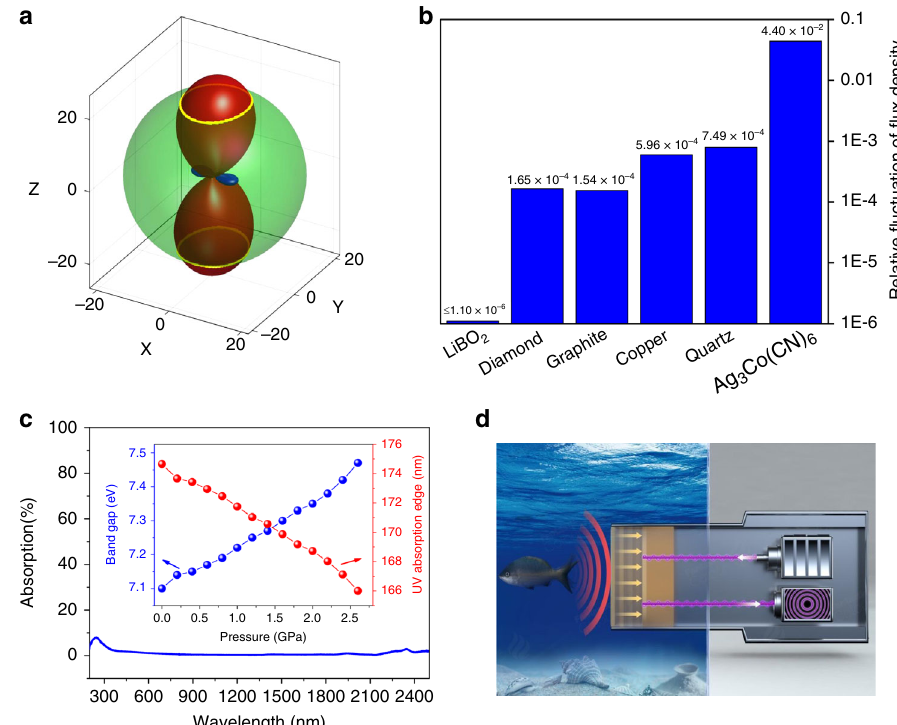
Fig. 3 Flux density stability, optical property, and potential application of LiBO 2 . a The matching between linear and volume compressibilities. Positive and negative linear compressibilities are represented by red and blue surfaces, and volume compressibility is represented by green sphere, respectively. The isoline between linear and volume compressibilities is highlighted by yellow curve. b Comparison of the relative fl uctuations of fl ux density among LiBO 2 and other materials, as they are moved from the sea level to Mariana Trench. c UV – Vis diffuse-re fl ectance spectrum. The calculated dependence of pressure vs. UV absorption edge (i.e., band gap) is shown in the inset. d Schematic for the ultrastable optical detection apparatus fabricated by LiBO 2 in the deep-sea